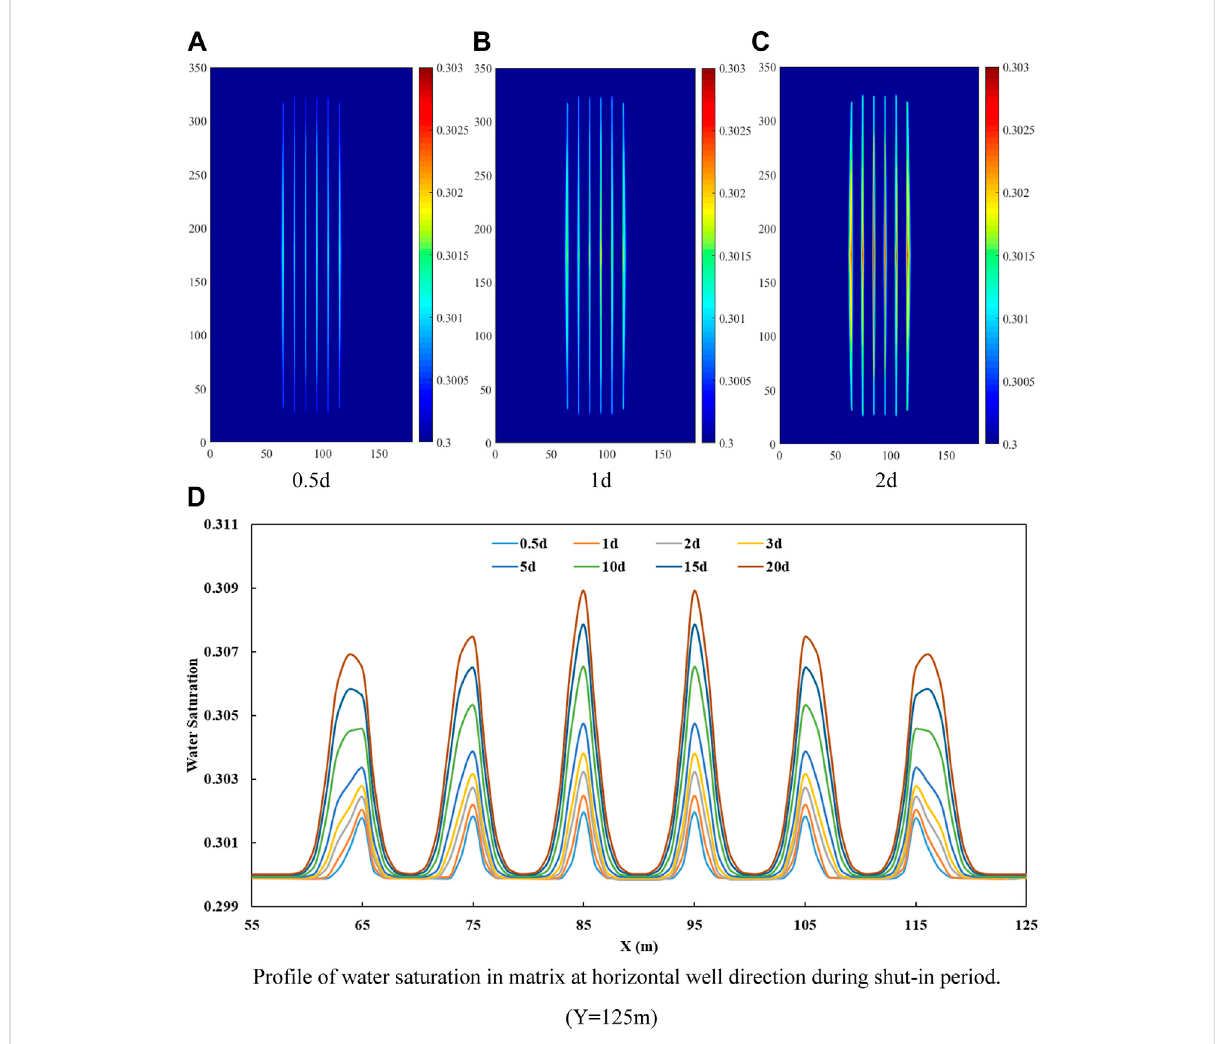
FIGURE 10 Distributionofwatersaturationinmatrixduringshut-inperiod.(In (A – C) ,therangeofwatersaturationisfrom0.3to0.303. (D) ispro fi leofwater saturation which is drawn from the data in the fi gure of water saturation distribution in matrix during shut-in period (such as (A – C) and so